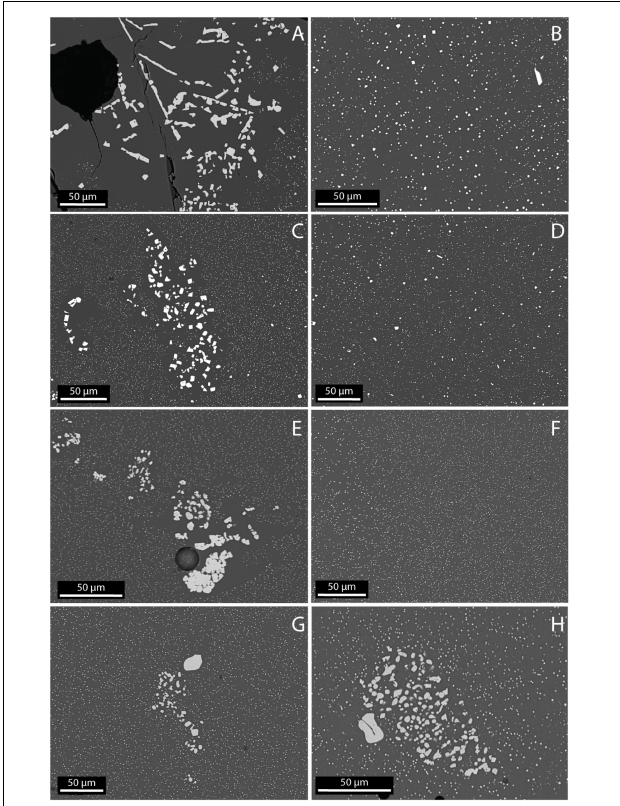
FIGURE 5 | SEM images of the samples recovered after the deformation experiment. Elongated spinel crystals nucleated during deformation or vermicular spinels grown during deformation have an aureole of microlite-free melt visible in SEM images. (A) Phenocrysts of spinels in the sample deformed at 2 × 10 − 5 s − 1 and its groundmass (B) . (C) Phenocrysts of spinels in the sample deformed at 6 × 10 − 5 s − 1 and its groundmass (D) . (E) Phenocrysts of spinels in the sample deformed at 1 × 10 − 5 s − 1 and its groundmass (F) . (G) Phenocrysts of spinels in the sample deformed at 2 × 10 − 4 s − 1 . (H) Phenocrysts of spinels in the undeformed sample. In panels (G,H) , no aureole of microlite-free melt is